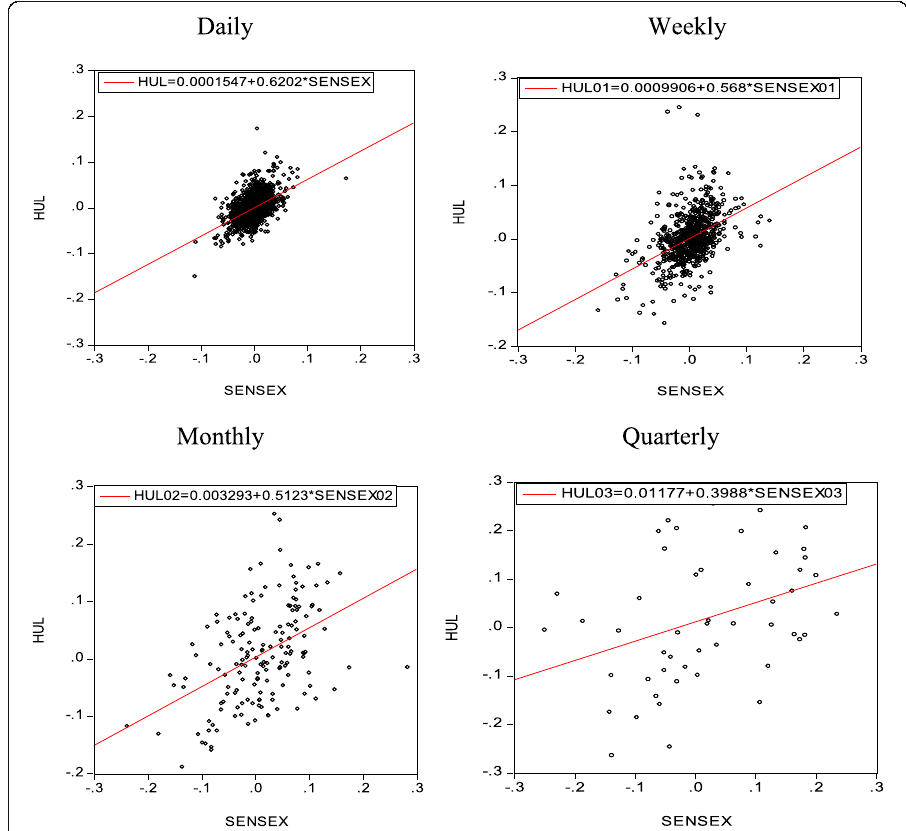
Fig. 1 Conventional decomposition of return series. Hindustan Unilever Limited (HUL) stock return (vertical axis) versus Sensex return, measured at different time periods. It can be noticed that the relation between a stock return (HUL) and the market (SENSEX) differs if the estimation is made with daily, weekly, monthly or quarterly. When the return interval is increased (changed) in a given sample period, the number of sample points decreases, which results in loss of